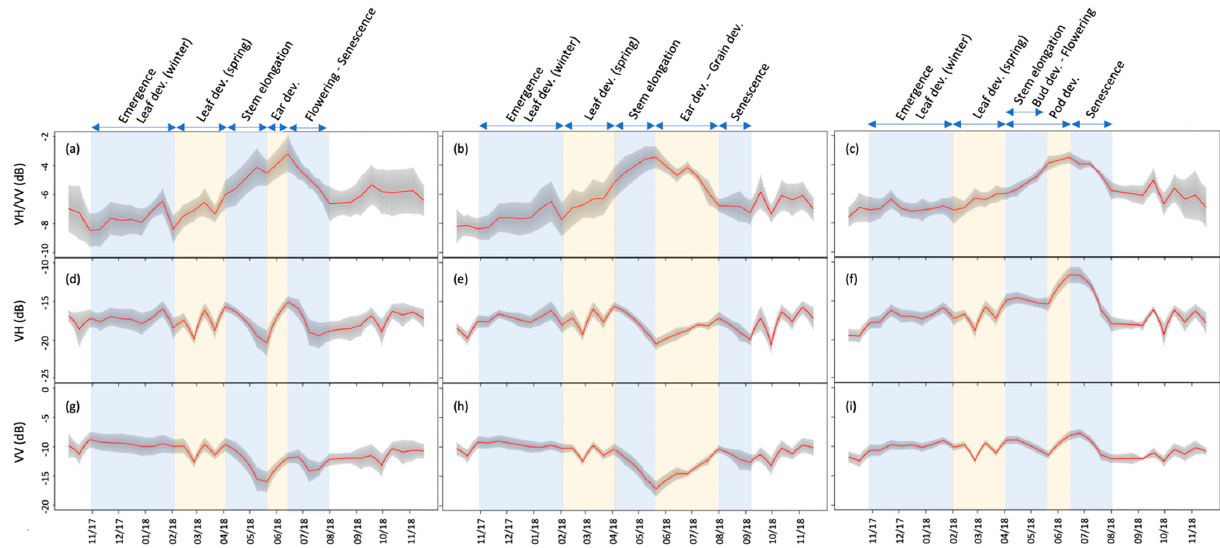
Figure 4. Median VH/VV, VH, and VV time series (in red) and standard deviation (in grey) for the ten plots of winter barley ( a,d,g ), winter wheat ( b,e,h ), and winter rapeseed ( c,f,i ) used for benchmarking. Key dynamics are indicated with reference to the knowledge-based crop growth stages.